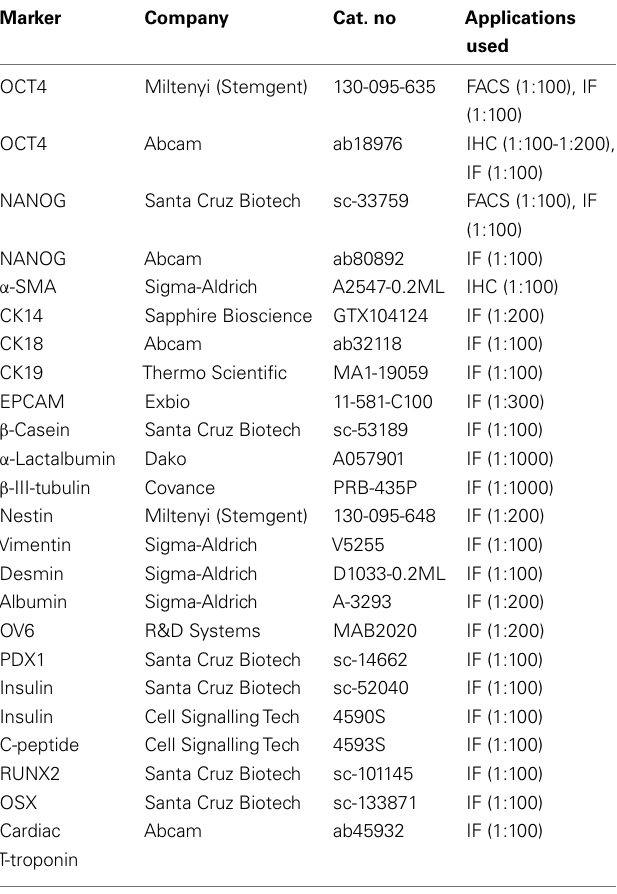
Table 1 | Markers examined. Table 2 | Scoring system for immunohistochemical quantification of OCT4 expression in the breast tissues examined.